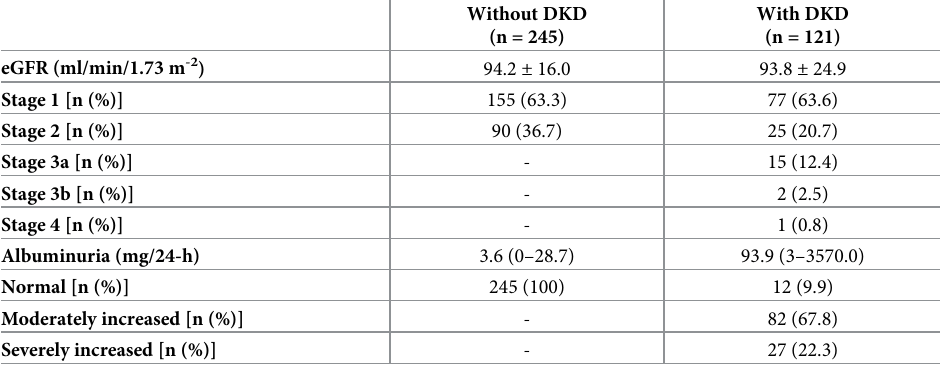
Table 2. Renal function status of patients with type 2 diabetes divided according to the presence or not of diabetic kidney disease.